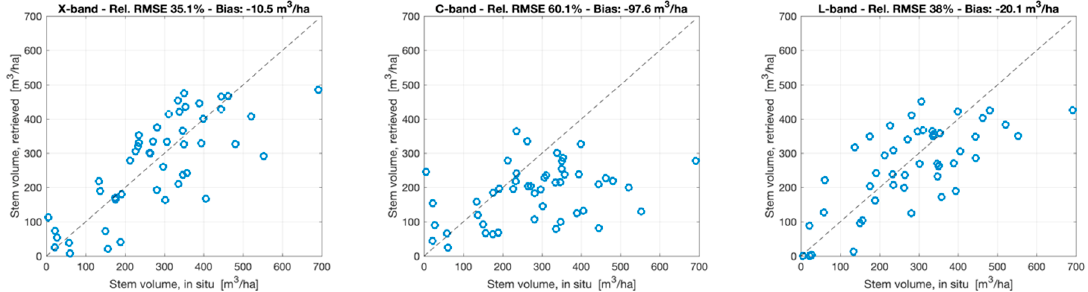
Figure 8. Scatter plots of measured and retrieved stem volume at Remningstorp for a multi-temporal and multi-polarization combination of estimates obtained at a given frequency band.